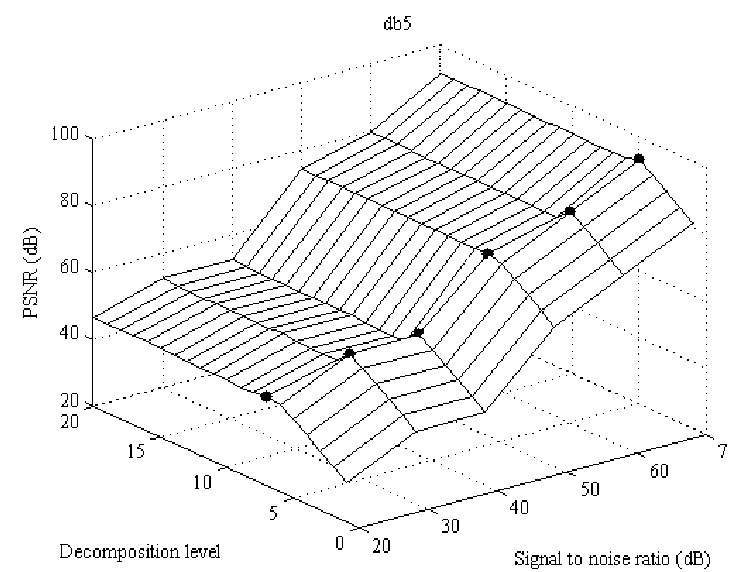
Figure 7. Noise reduction for db5 as a function of decomposition level and SNR.